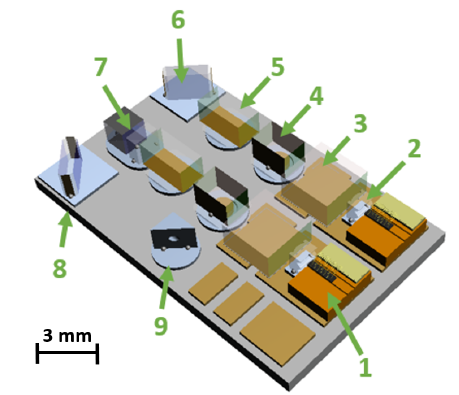
Figure 1. Exomars laser drawing with all the components assembled. (1) Pumping diodes. (2) FAC. (3) Active crystal. (4) SHG-BBO. (5) Fused Silica (FS) output laser cavity mirror. (6) Folding mirror. (7) Lambda half and polarization combiner cube. (8) Folding mirror in front of a power feedback photodiode. (9) Pinhole-mirror in front of an autofocus